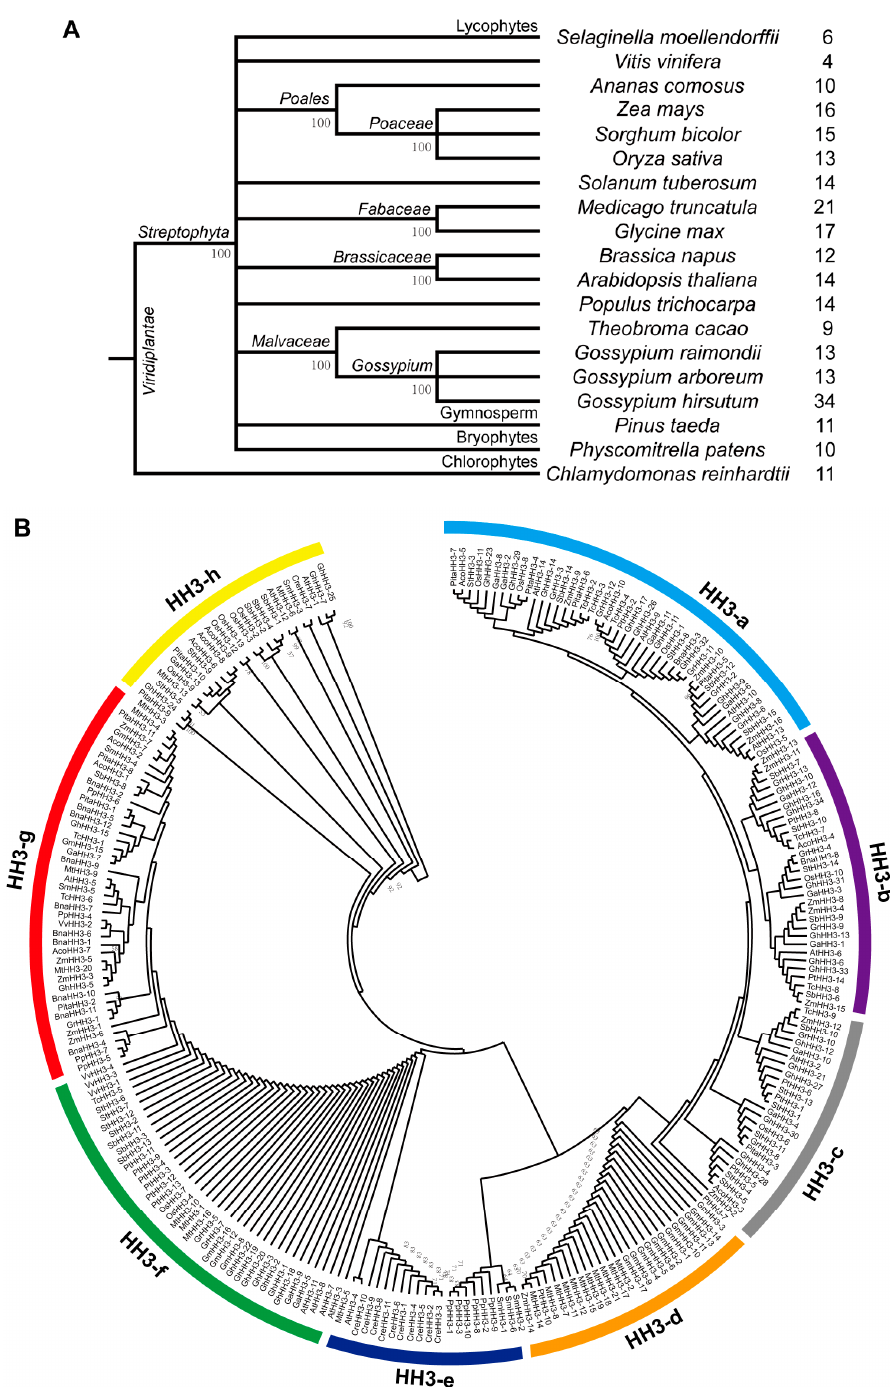
Figure 1. Phylogenetic tree of histone H3 ( HH3 ) genes from 19 plant species. ( A ) The phylostratum analysis of the HH3 gene family. ( B ) Phylogenetic tree divided all 257 HH3 genes into eight clades from HH3-a to HH3-h. Bootstrap values were also mentioned near the node of each branch.